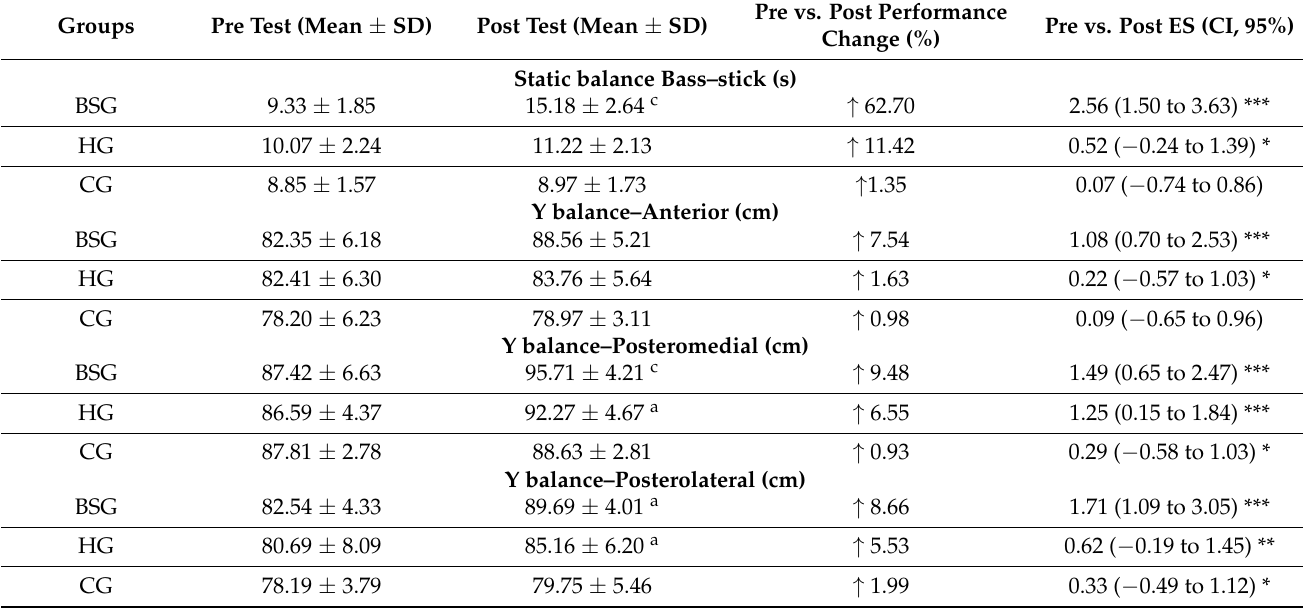
Table 4. Training effects (with CI, 95%) for the balance and function variables between